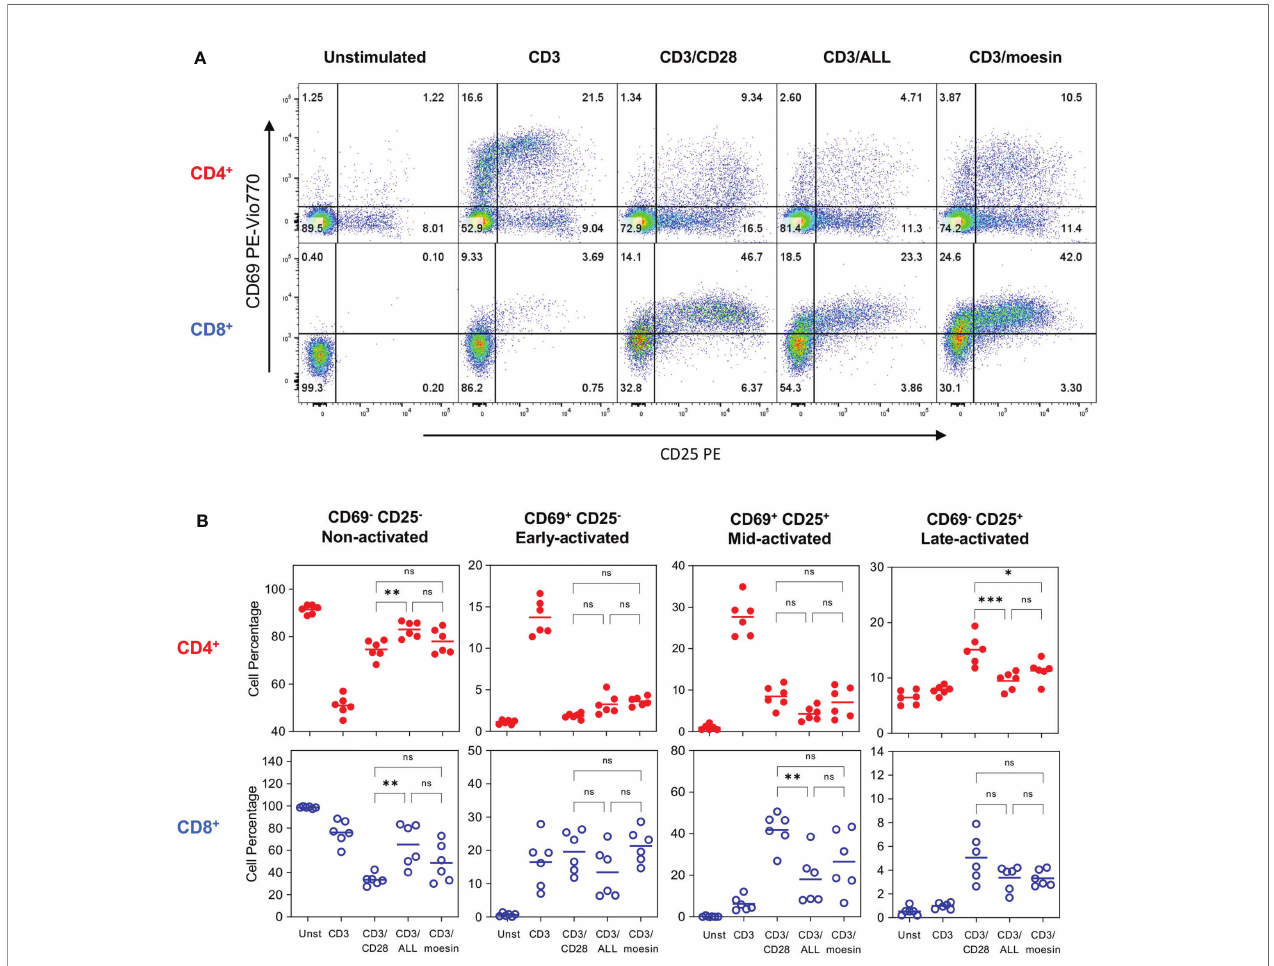
FIGURE 5 | Moesin costimulation induces the expression of activation markers in T lymphocytes. Splenocytes were stained with CFSE, then, T cells were isolatedby negative selection and activated with anti-CD3 and anti-CD28 mAbs (CD3/CD28), anti-CD3 and ALL (CD3/ALL), or anti-CD3 and anti-moesin mAb (CD3/moesin) and collected after 72h. Samples were stained with anti-CD4, anti-CD8, anti-CD69, anti-CD25, Ghost Dye Red 780, and analyzed by fl ow cytometry. Lymphocytes were de fi ned by FCS and SSC characteristics, after singlets selection, dead cells were excluded, and the activation markers were analyzed within the CD4+CD8- and CD4-CD8+ subsets. Representative analysis of CD69 and CD25 expression pattern in CD4+ and CD8+ T cells (A) , the gates indicate 4 activation stages: CD69-CD25- (Non-activated), CD69+CD25- (Early activated), CD69+CD25+ (Mid-activated) and CD69+CD25+ (Late activated). (B) Percentages of the cell proportions at each activation stage after stimulation with anti-CD3 and each costimulatory molecule from 2 independent experiments with 3 mice per group. Data were analyzed using one-way ANOVA followed by Bonferroni ’ s multiple comparison test between the indicated conditions. ns, not signi fi cant, *p < 0.05 **p < 0.001, ***p < 0.001. Additional controls performed in this experiment included cells stimulated with anti-CD28, ALL or anti-moesin only, anti-CD28/ALL, or anti-CD28/anti- moesin areshown in Supplementary Figure 1